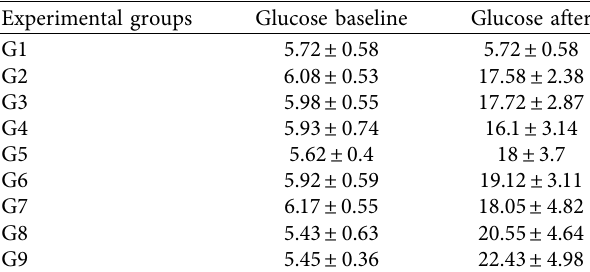
Figure 9: Microbial growth curve of Staphylococcus aureus postwound infliction on the different postwound treatment groups. Table 4: Fasting blood sugar level of experimental groups before and after treatment.